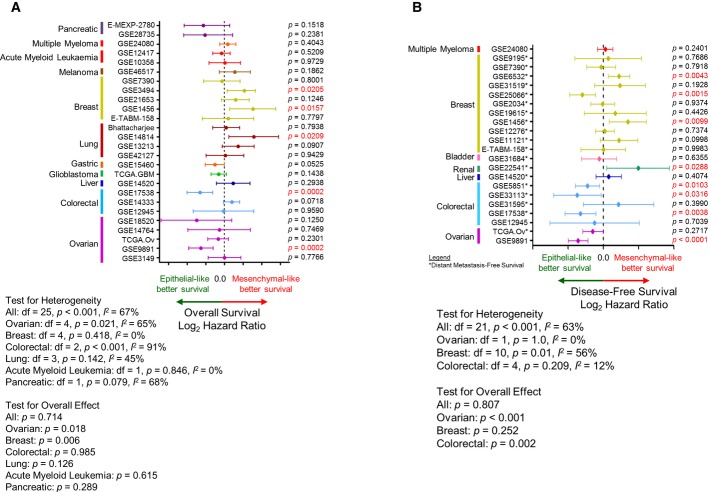
Correlation of Epithelial-mesenchymal transition (EMT) scores and survivalA, B Plot of log2 hazard ratio (HR; mean ± 95% confidence interval) comparing (A) overall survival (OS) and (B) disease-free survival (DFS) of Epi and Mes tumours in different cancers and cohorts. DFS includes progression-free, recurrence-free and distant metastasis-free survival (cohorts inclusive of distant metastasis-free survival were indicated with *). CorrespondingP-values from the log-rank test are given next to each cohort, and those with significant differences (P < 0.05) are marked red. Log2 HR < 0.0 indicates Epi tumours with survival benefit, whereas log2 HR > 0.0 indicates Mes tumours with survival benefit. Meta-analysisP-value for effect or heterogeneity was computed using DerSimonian–Laird binary random effect (for overall) or Peto fixed effect method (for individual cancer).